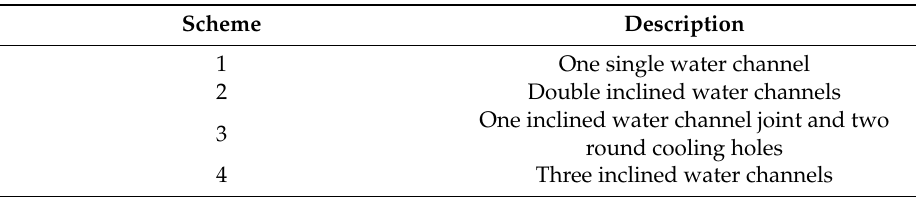
Table 6. Water channel design schemes of the mold.